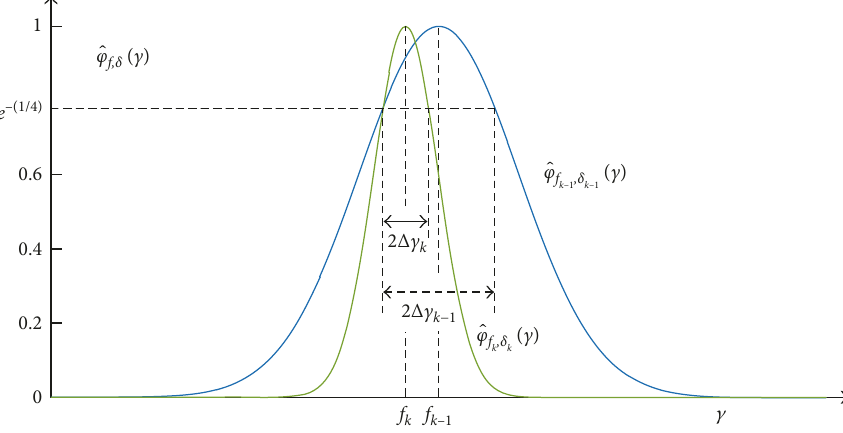
Figure 3: The second situation of two adjacent Morlet